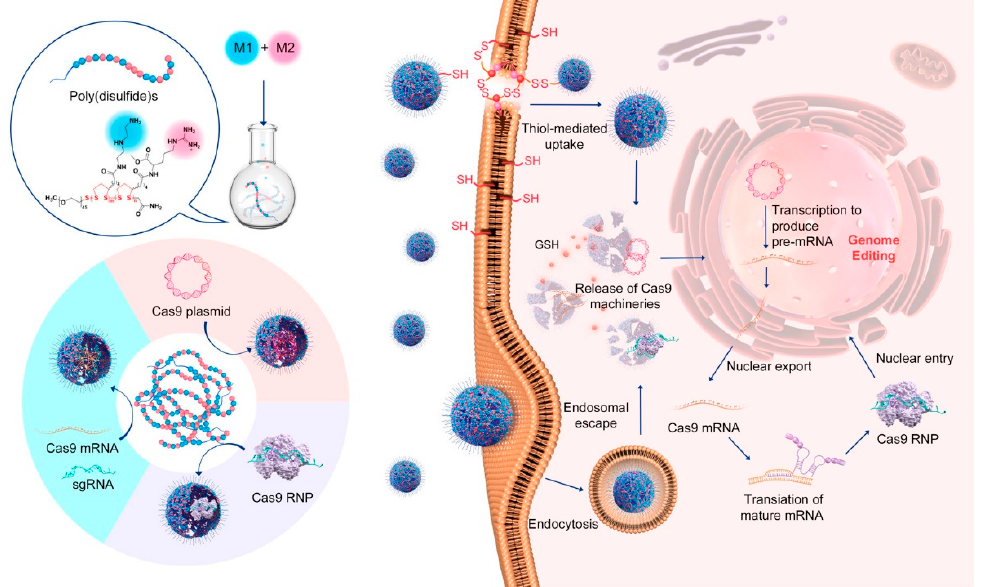
Figure 5. Schematic illustration of the preparation of poly(disulfide)s, the complexation of genome editing biomacromolecules (Cas9 plasmid, Cas9 mRNA, and Cas9 ribonucleoprotein) by poly(disulfide)s, and their intracellular delivery processes for genome editing. Reproduced from ref. [141] with permission from the American Chemical Society.